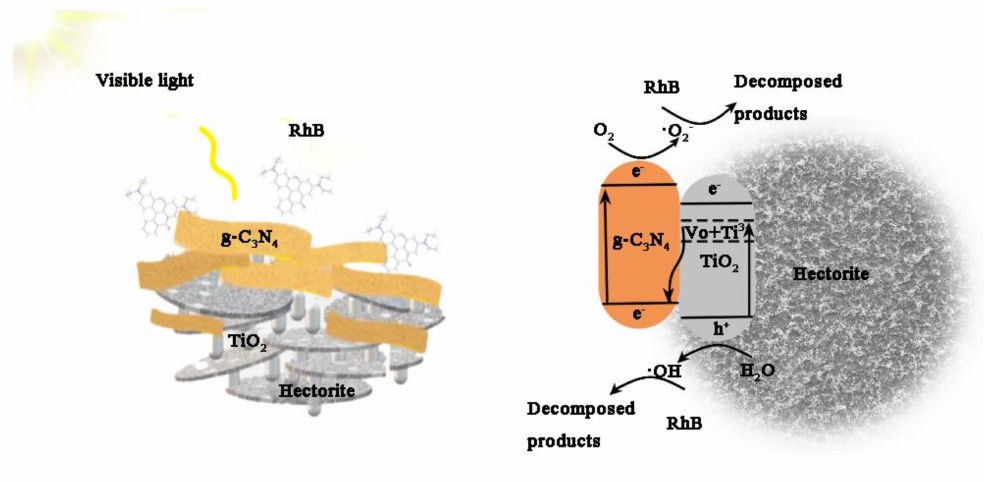
Scheme 1. Schematic diagram of the enhancement mechanism for the degradation process under visible light towards g-C 3 N 4 / TiO 2 / hectorite composite.